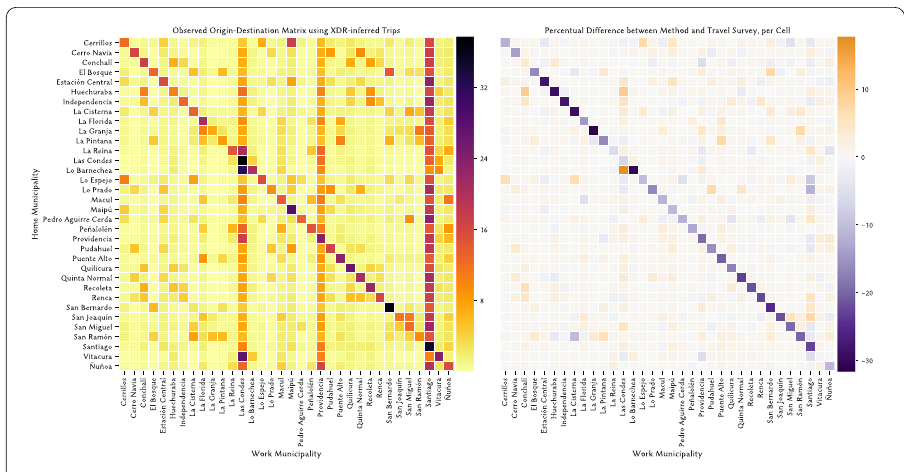
Figure 8 Origin-Destination (OD) matrix from XDR-inferred commuting trips (left). Rows are home municipalities, columns are work municipalities. The matrix on the left is row-normalized and then multiplied by 100 to ease interpretability. The matrix on the right shows the difference with an OD matrix built from the Santiago Travel Survey held in 2012. Each cell in this second matrix is colored with a divergent color palette: grey cells show similar values, orange cells depict OD pairs where XDR infers more trips, and purple cells depict OD pairs where the Travel Survey reports more